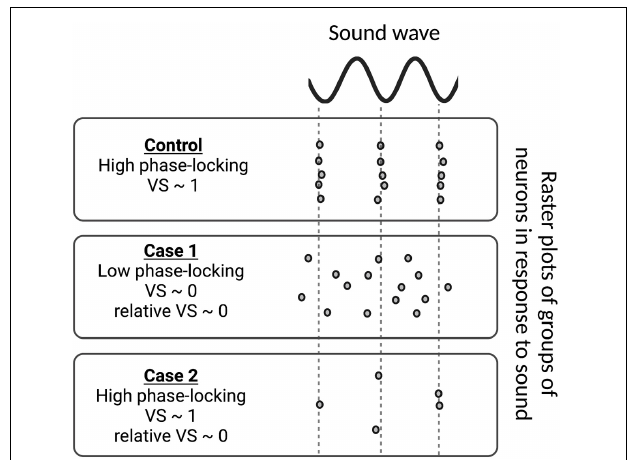
FIGURE 7 | Examples of vector strength (VS) and relative VS measurements for various groups of neurons in response to sound stimulus. In the control case, the spike times of all neurons are phase-locked to the sound wave, i.e., they always fire at the same phase of the sound wave and VS approaches 1. In Case 1, phase-locking is low, resulting in a VS ∼ 0. As the number of spikes is the same as the control in Case 1, VS and relative VS are the same. However, the group of neurons in Case 2 does not fire nearly as much as the control case, leading to low relative VS, even though its VS is